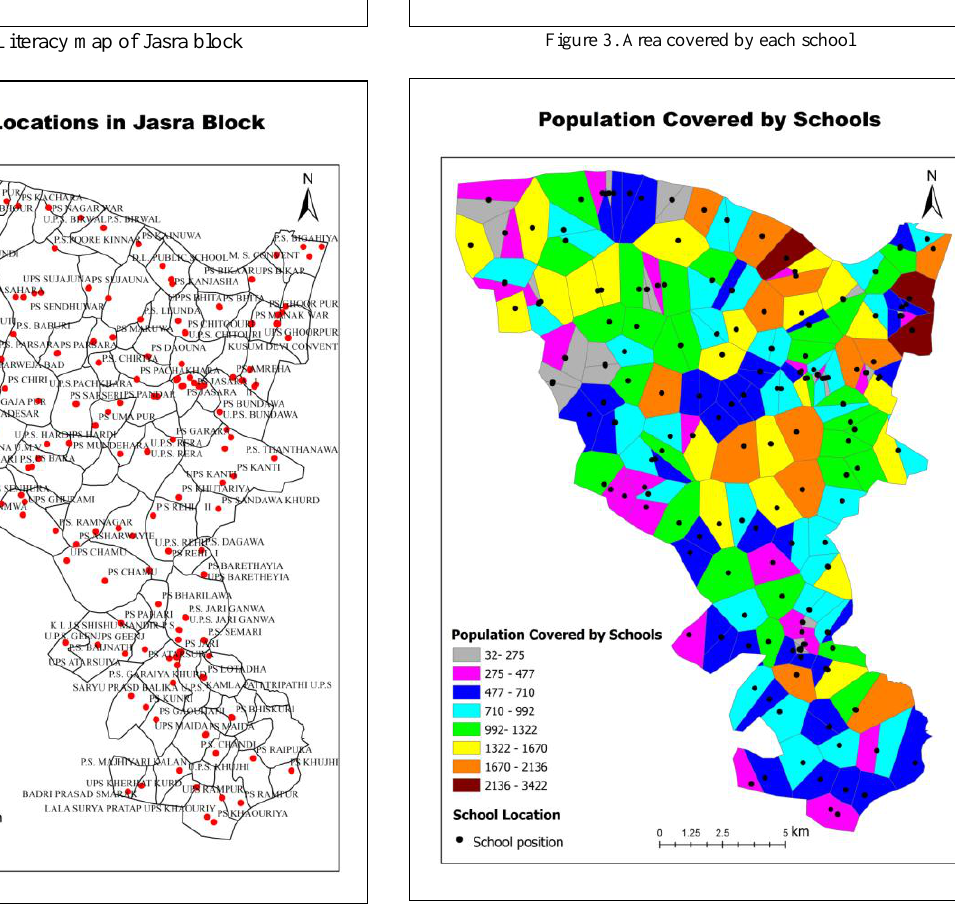
Figure 2. Location of schools collected by GPS survey